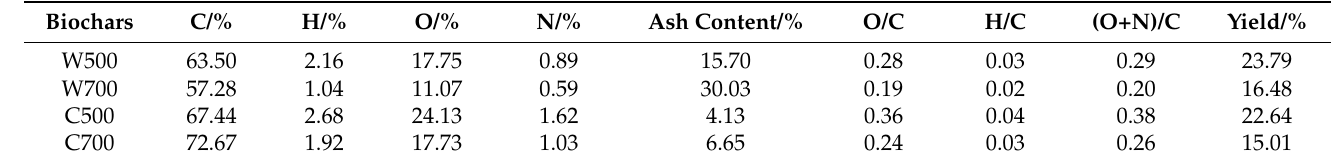
Table 1. Elemental composition, ratio, and yield of biochars.